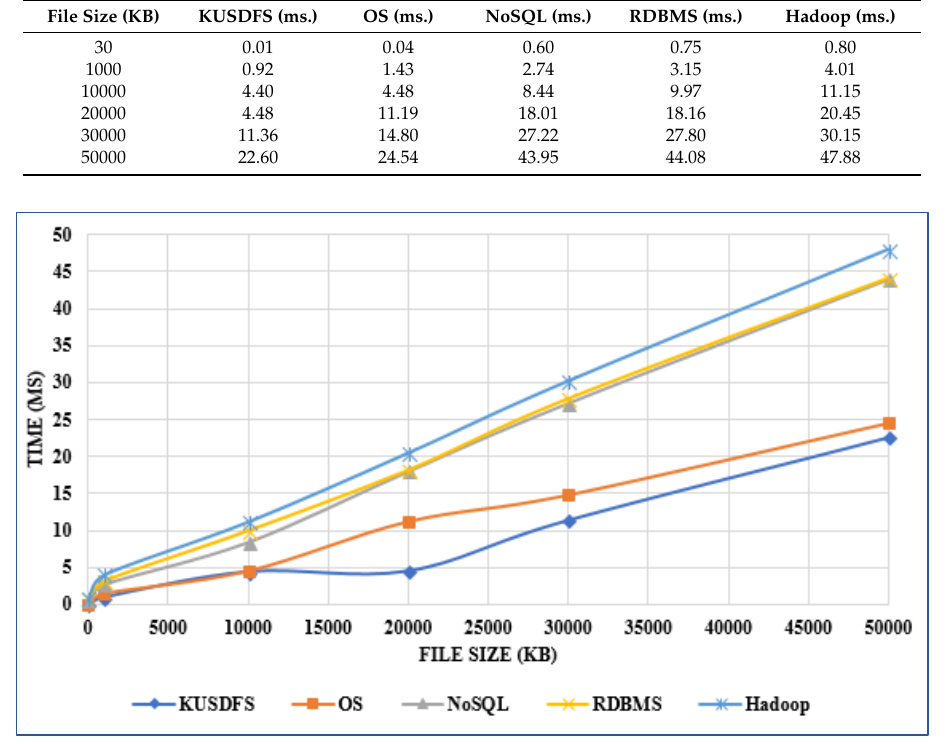
Figure 8. The response times given by the systems for different file size (ms.).